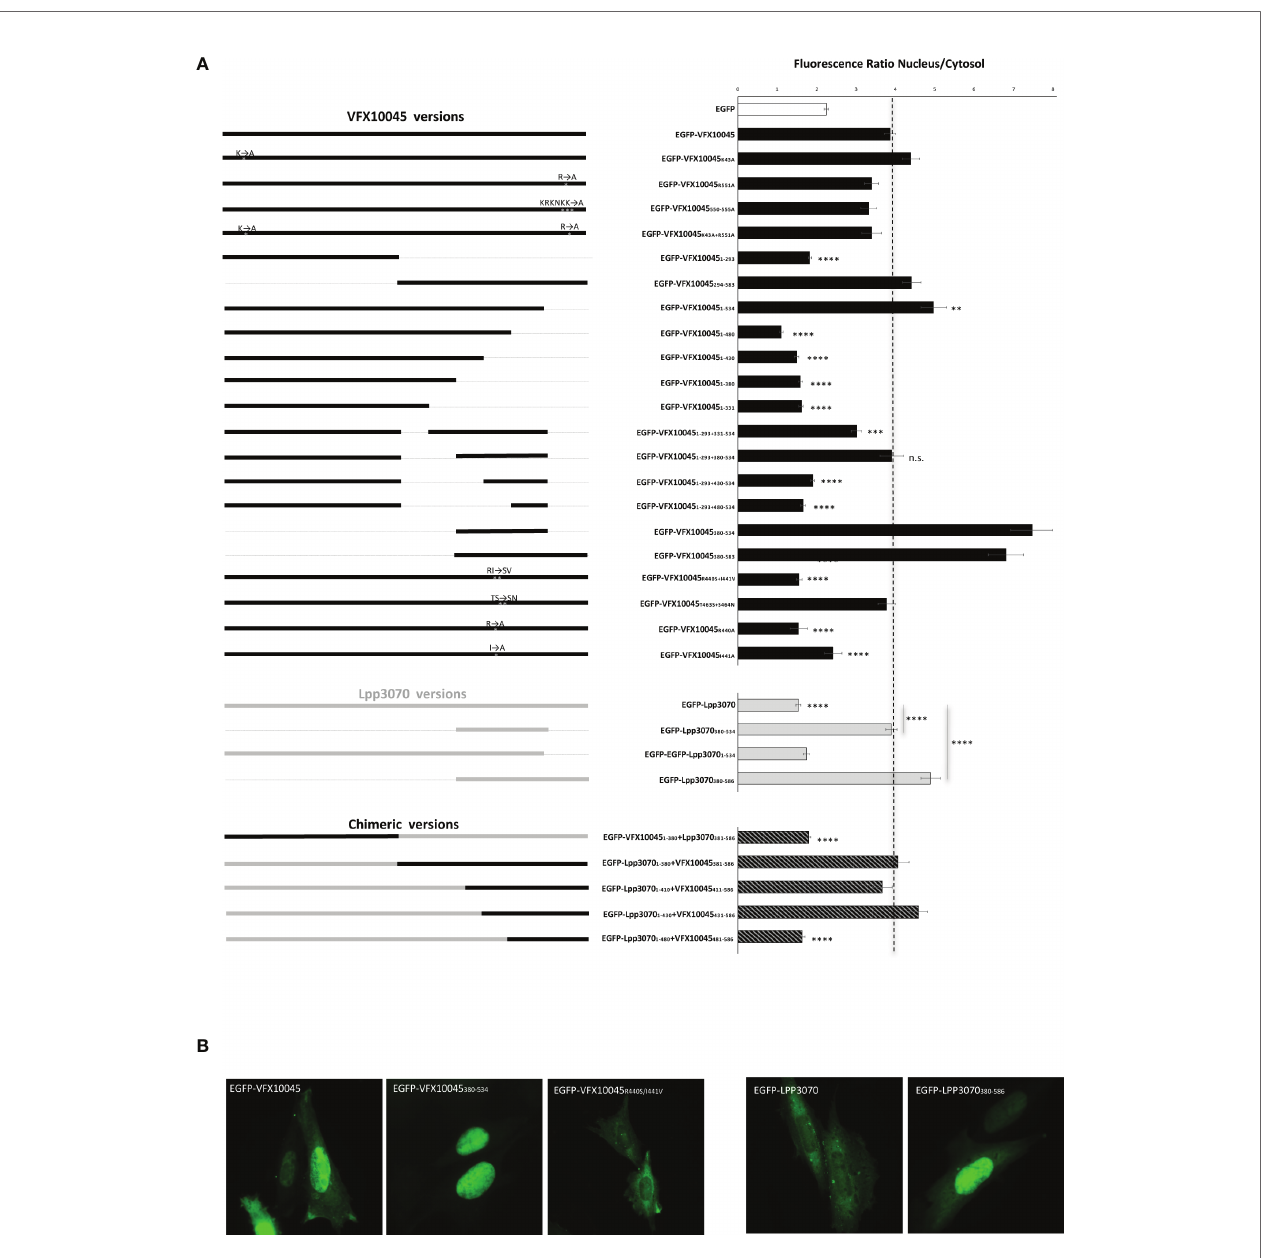
FIGURE 5 | Effect of mutations on the subcellular localization of L. pneumophila effectors VFX10045 and LPP3070 in CHO cells. Plasmids encoding GFP fusions to different versions of L. pneumophila Icm/Dot substrates VFX10045 and Lpp3070 were used to transiently transfect CHO cells (representative images are shown in Supplemental Figure S5 ). (A) Graphical depiction of constructs (left; black bars, VFX10045 protein regions; grey bars, Lpp3070 protein regions; striped bars, chimeric proteins) and corresponding ratios of protein present in nucleus relatively to cytosol (right; Ratio Nucleus/Cytosol), calculated after quanti fi cation of the total GFP fl uorescence in each of the two cell compartments in ImageJ. Bars, averages; error bars, standard error of the mean. For comparison a dashed line indicates the value obtained for full-length VFX10045. The results were obtained from the quanti fi cations of three independent experiments, with a total of at least 60 cells analysed. Statistical analysis was made with student T-test by comparison with wild-type VFX10045 or with the indicated proteins; **, p<0.01; ***, p<0.001; ****, p<0.0001; n.s., non-signi fi cant. (B) Representative microscopy images of the indicated